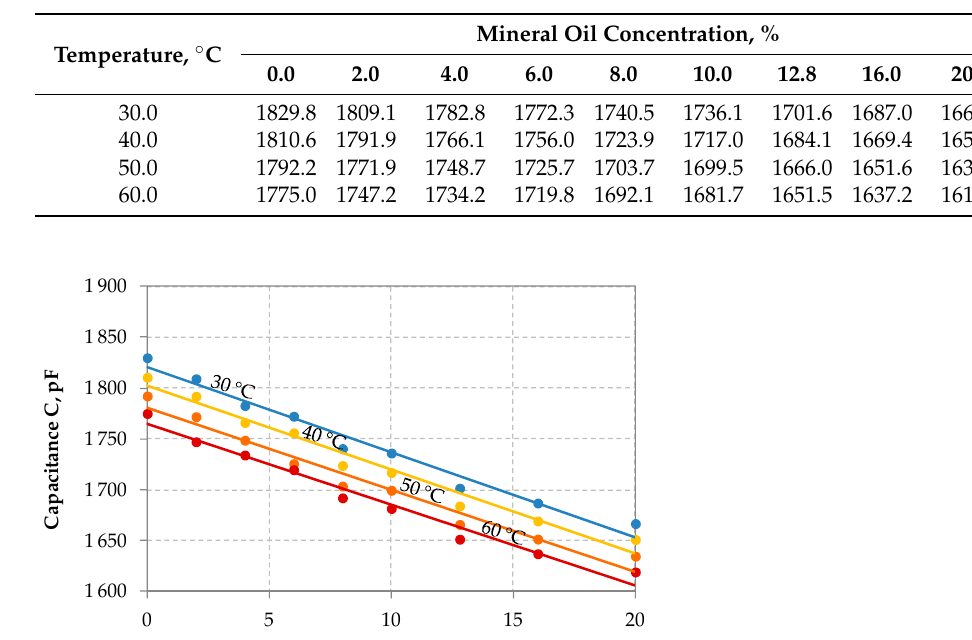
Table 3. Measurement results of the capacity of a trimmer immersed in a mineral oil and synthetic ester mixture as a function of oil concentration.